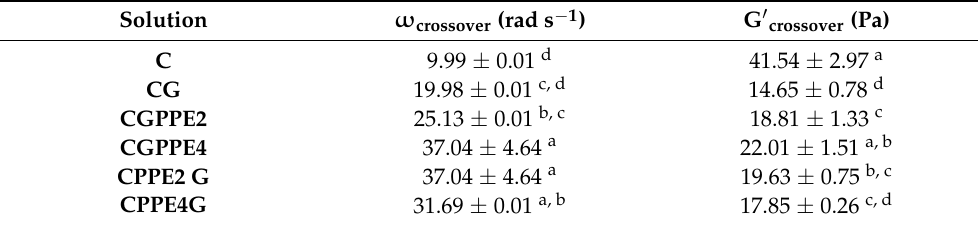
Table 2. Parameters determined by frequency sweep measurements: angular frequency at the crossover point ( ω crossover ) and G (cid:48) modulus at the crossover point (G (cid:48) crossover ). Measurements performed at γ = 10% and 25 ◦